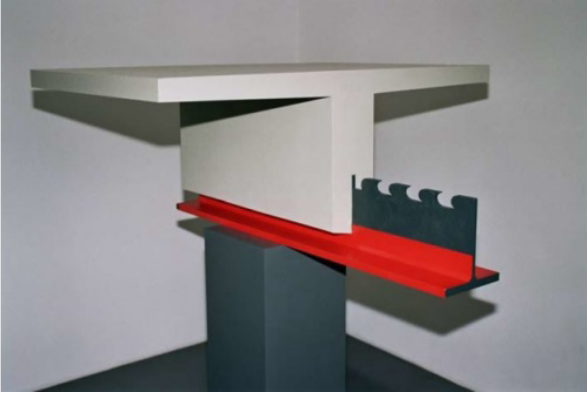
Figure 3: Model of the “PreCo-Beam” girder (picture and model by